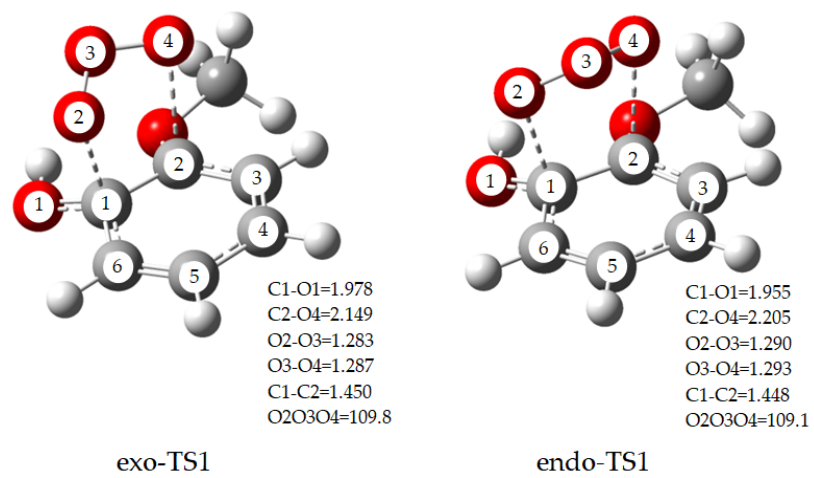
Figure 1. MPWB1K / 6-31G(d,p) optimized geometries for exo-TS1and endo-TS1 of guaiacol with main Figure 1. MPWB1K/6-31G(d,p) optimized geometries for exo-TS1and endo-TS1 of guaiacol with bond lengths and bond angles. Angles are in degree and bond lengths are in main bond lengths and bond angles. Angles are in degree and bond lengths are in Å.